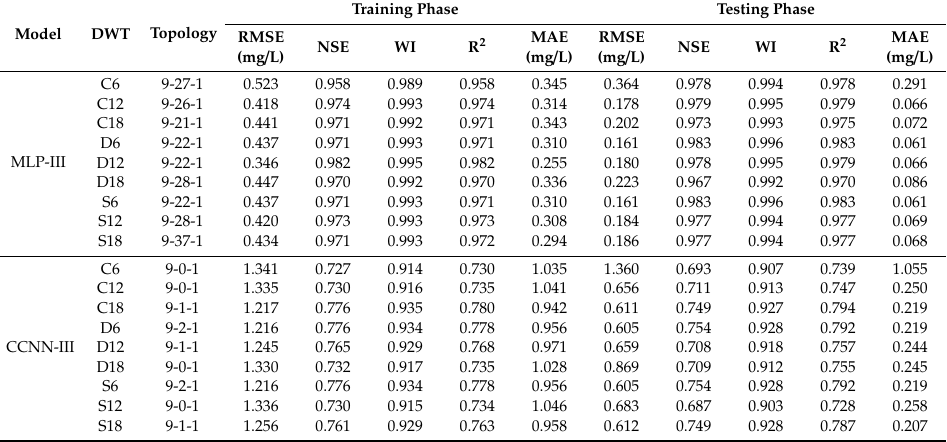
Table 4. Performance statistics using DWT-MLP-III and DWT-CCNN-III